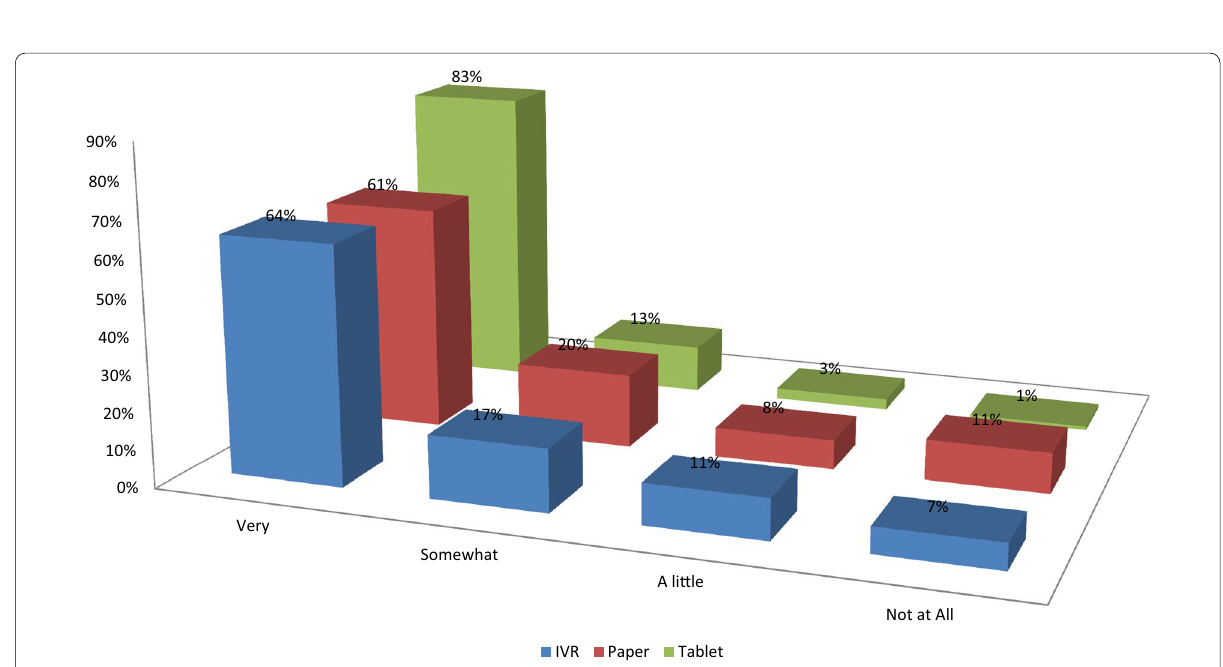
Fig. 4 How willing to use touchscreen computer or tablet